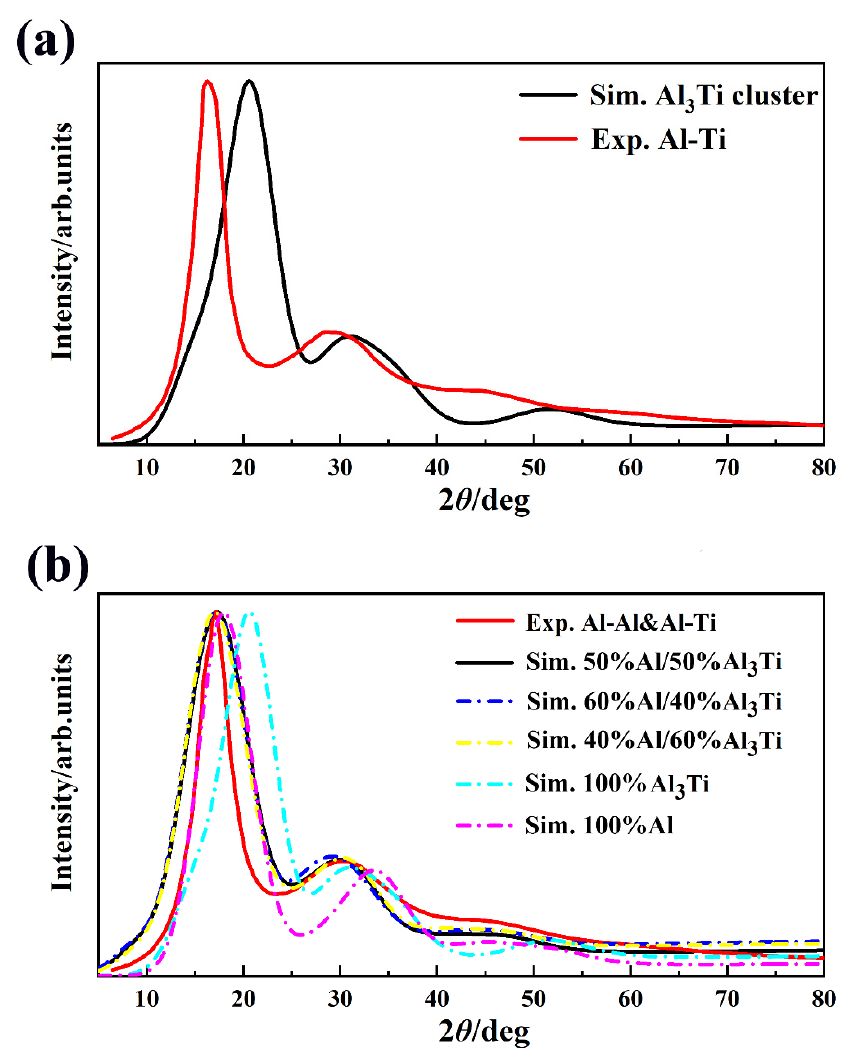
Figure 6. Comparison of the combination of Al–Al and Al–Ti partial XRD pattersn (red line) with simulated lines of: ( a ) Al 3 Ti cluster; ( b ) combination of simulated XRD result of pure Al and Al3Ti cluster with different composition ratios.